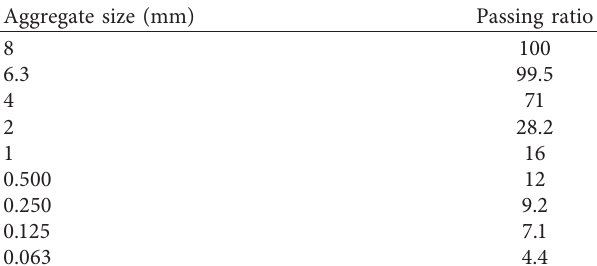
Figure 2: Gradation of crumb rubber particles. Table 2: Passing ratio of aggregates.